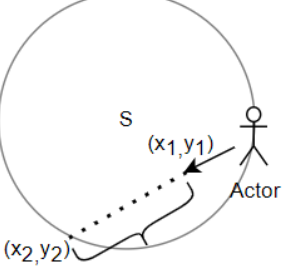
Figure 4. Campaign revenue model (users within the service).